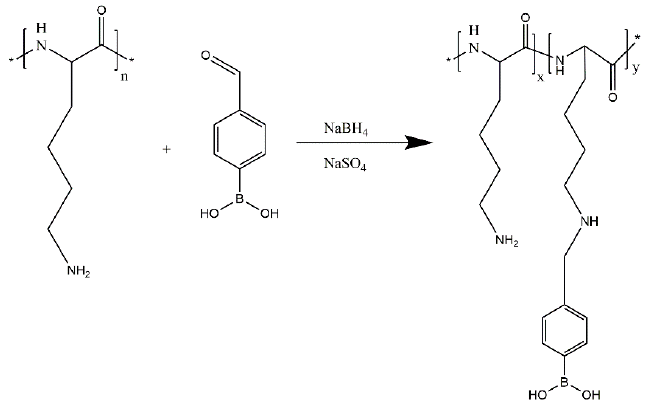
Figure 6. Synthesis route of PLL-B.